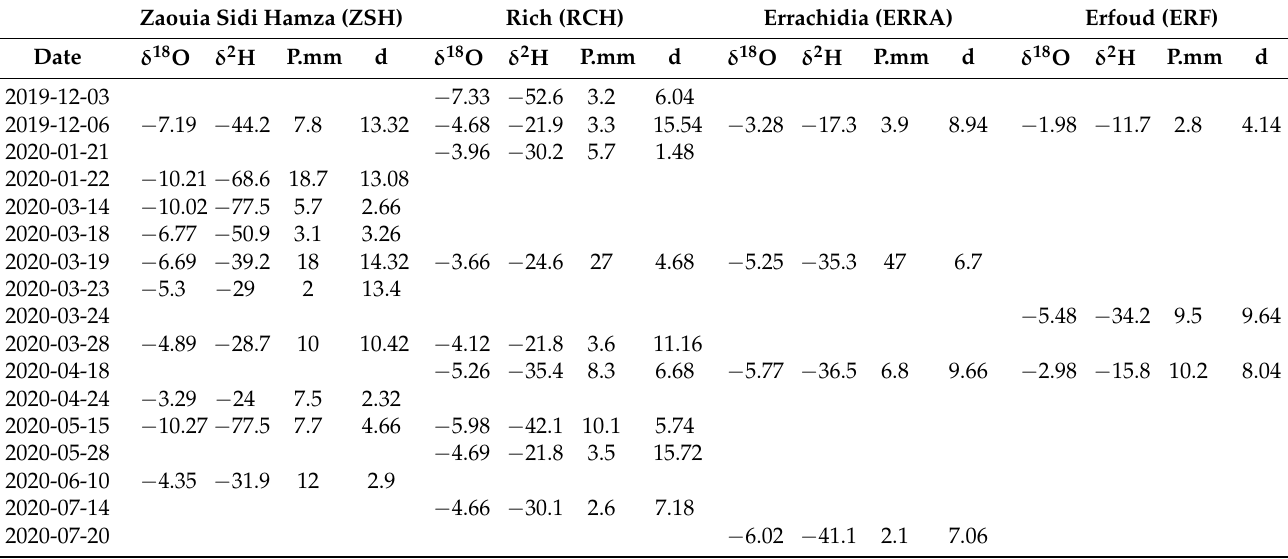
Table 3. Results of the isotope analysis, deuterium excess “d”, and precipitation (P). Zaouia Sidi Hamza (ZSH) Rich (RCH) Errachidia (ERRA) Erfoud